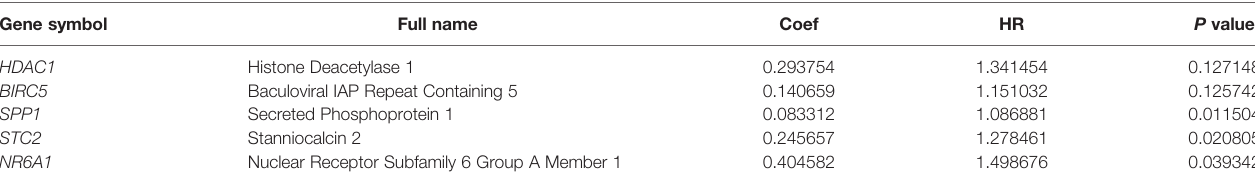
TABLE 1 | Genes contained in the prognostic model of hepatocellular carcinoma. Gene symbol